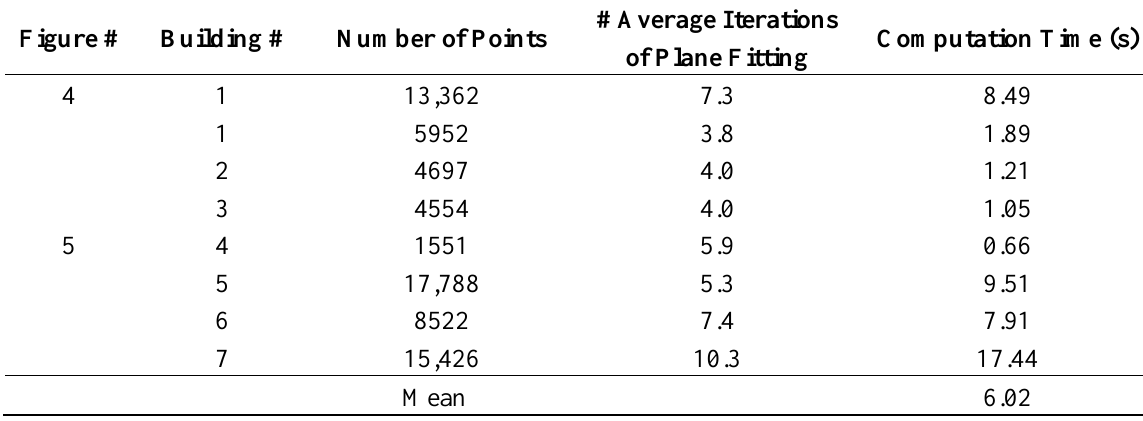
Table 3. Computational performance of individual building. Building